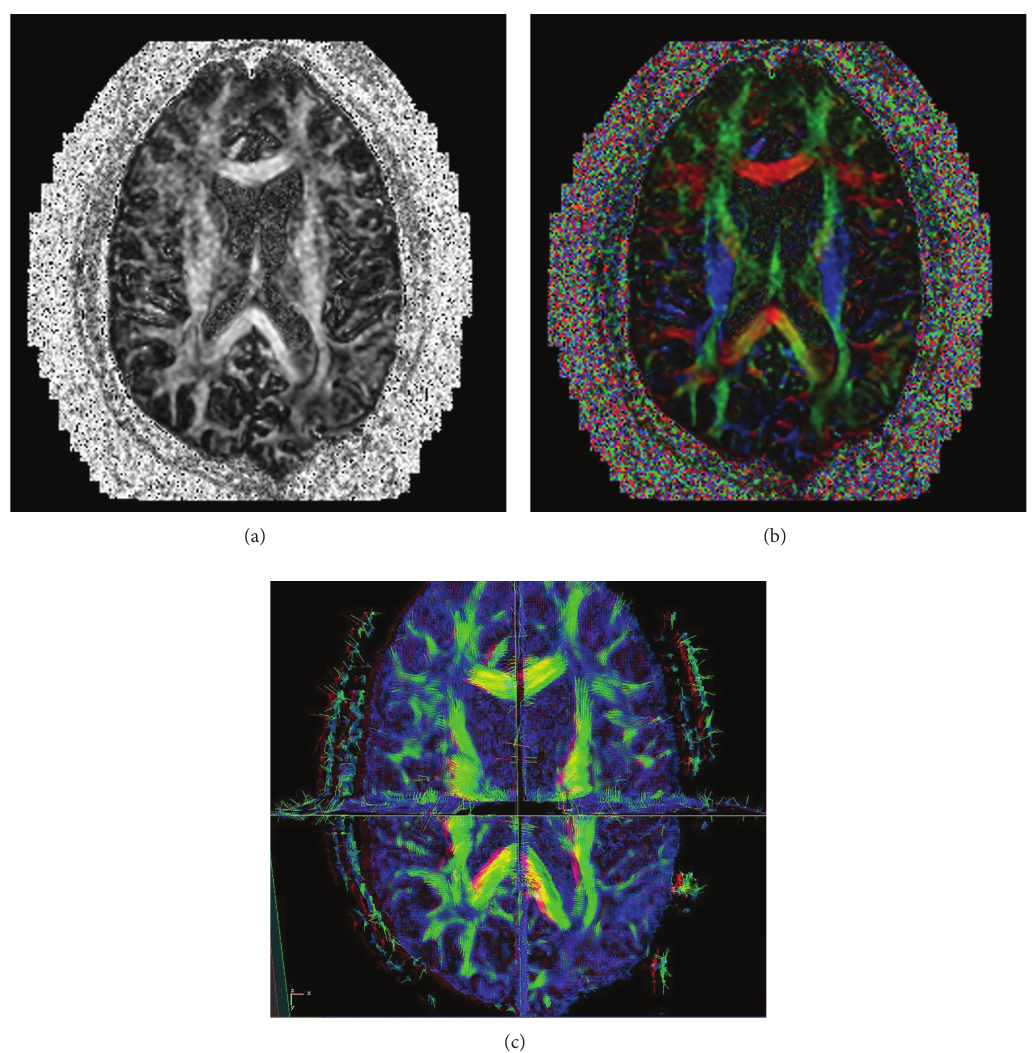
Figure 1: For comparison, the principal eigenvectors are presented in (grayscale (GSFA) map, color coded orientation view (CCOM), and headless arrow view ( 𝑉 max )). (a) GSFA. The intensity represents the FA value while no directional information is given. (b) CCOM. In the color coded orientation view, which is commonly seen in today’s DTI literature, blue color represents the craniocaudal (in-out of paper) direction, red represents the left-right direction, and green represents the anterior-posterior (up-down) direction. The mixed colors represent directions somewhere in between. The intensity of color represents the FA value. (c) 𝑉 max map. In the stereoscopic view, eigenvectors’ directional information is presented intuitively as headless arrows in 3D stereoscopically and colors represent the FA